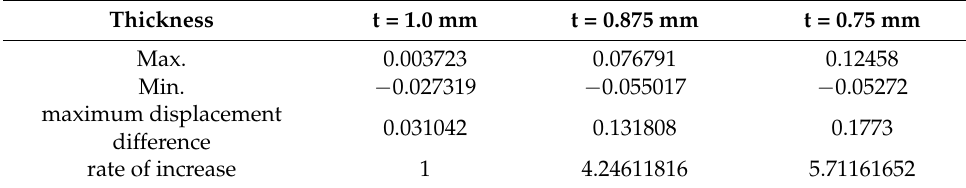
Table 3. Vibration displacement according to PVDF piezoelectric material thickness.